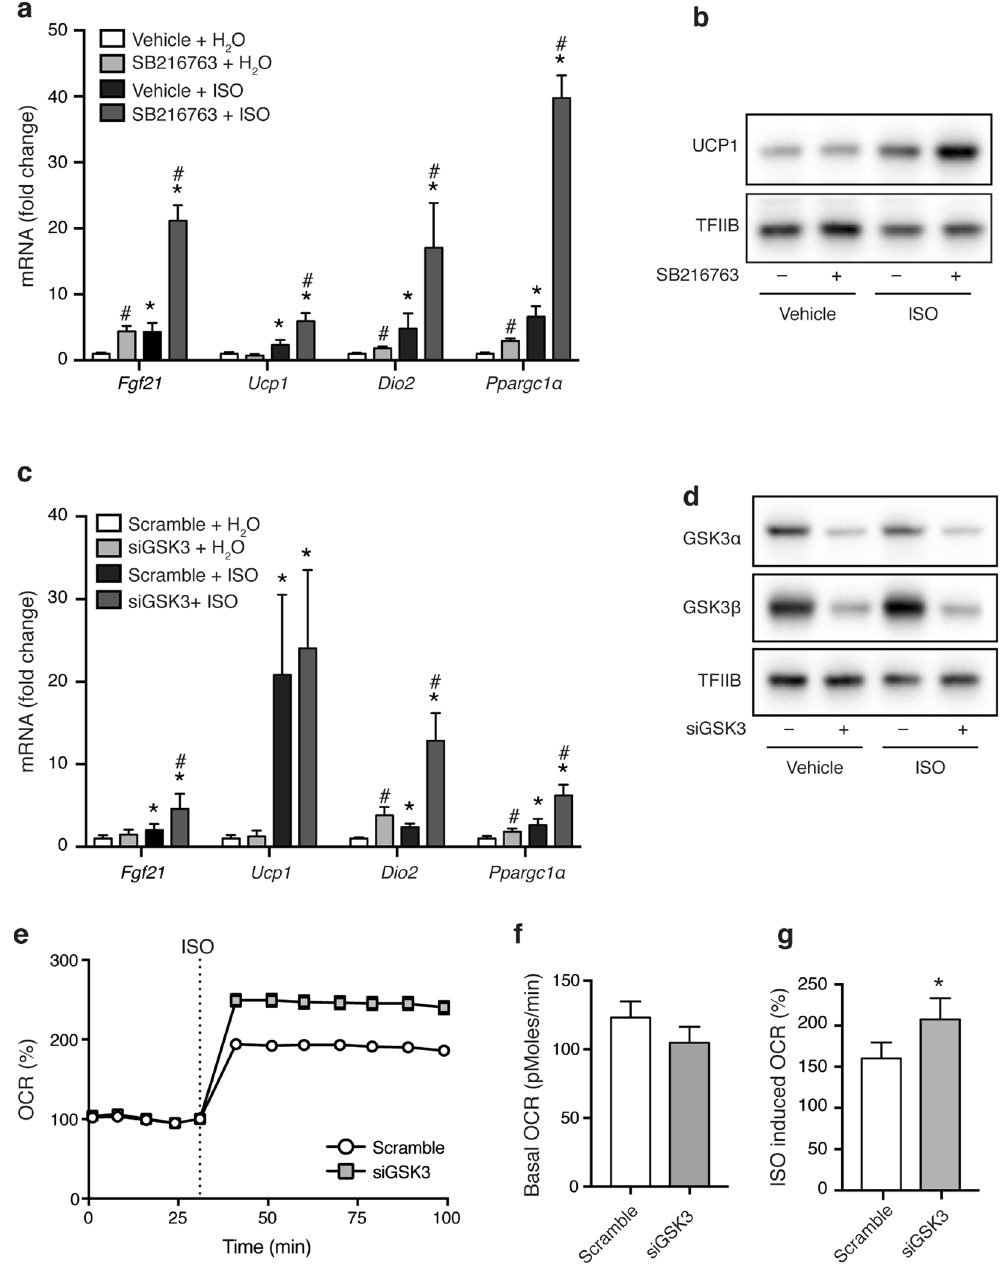
Figure 3. GSK3 restricts the thermogenic program in brown adipocytes. ( a ) Expression of thermogenic genes ( Fgf21 , Ucp1 , Dio2 and Ppargc1 α ) in primary brown adipocytes pre-treated with 10 μ M SB216763 for 1 h before being stimulated with 0.1 μ M ISO for an additional 6 h. ( b ) Immunoblot analysis of UCP1 in primary brown adipocytes pre-treated with 10 μ M SB216763 for 1 h before being stimulated with 0.1 μ M ISO for an additional 24 h. TFIIB serves as loading control. ( c ) Expression of thermogenic genes ( Fgf21 , Ucp1 , Dio2 and Ppargc1 α ) in siRNA-transfected primary brown adipocytes stimulated with 0.1 μ M ISO for 6 h. ( d ) Immunoblot analysis of GSK3 α and GSK3 β in siRNA-transfected primary brown adipocytes stimulated with 0.1 μ M ISO for 24 h. TFIIB serves as loading control. ( e ) Representative normalized Seahorse run of oxygen consumption rates (OCR) in siRNA-transfected primary brown adipocytes. Quantification of basal ( f ) and ISO (1 μ M)-induced ( g ) OCR. RT-qPCR data are presented as mean of means ( + SEM) (n = 4). Statistical significance was determined by two-way ANOVA with repeated measures and Tukey’s post hoc test for multiple comparisons. * p < 0.05 versus H 2 O. # p < 0.05 versus vehicle/scramble. Seahorse data are presented as mean ( ± SEM) of one representative experiment ( e ) or 3 independent experiments (f,g ) and significance was determined by paired t-test ( * p < 0.05). For panels b and d, full-length blots/gels are presented in Supplementary Fig.